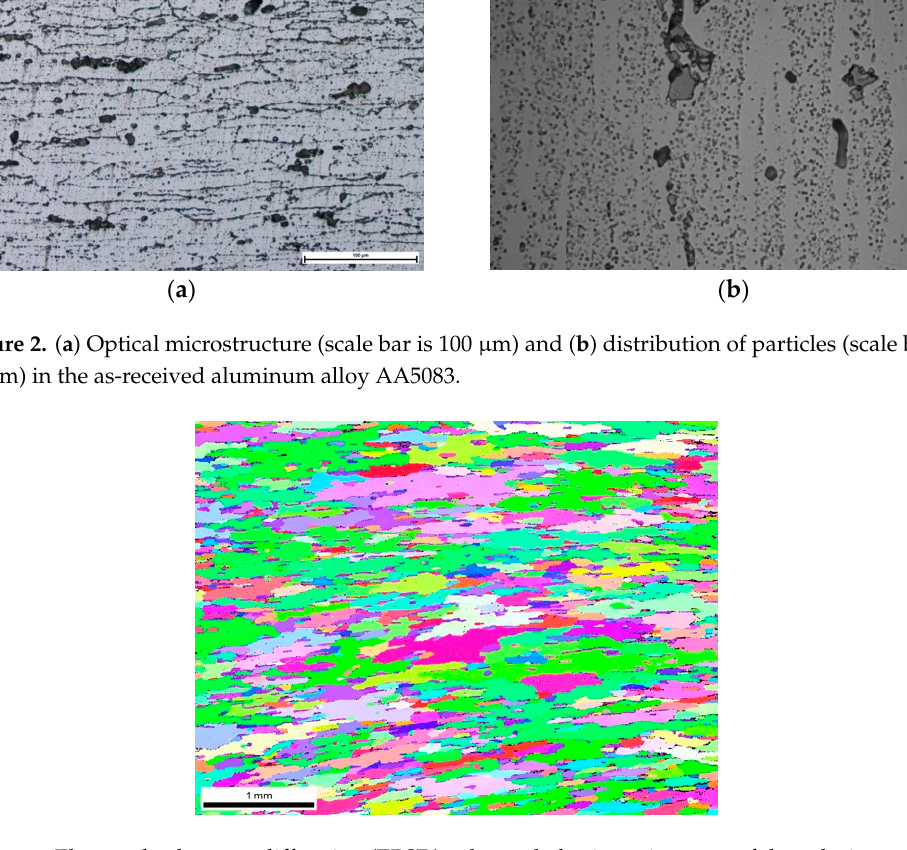
Figure 3. Electron backscatter diffraction (EBSD) color-coded orientation map of the solution-treated AA5083 (step size is 5 μ m).